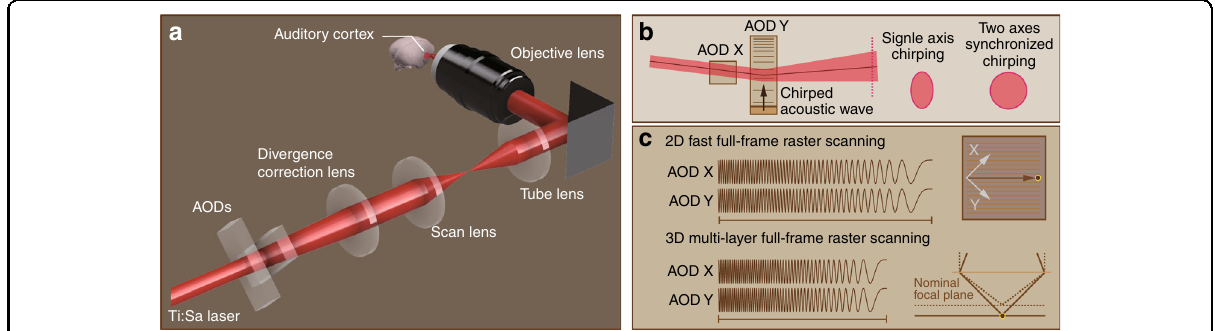
Fig. 1 Con fi guration for silent raster scanning using two AODs. a Excitation light from a Ti:Sa laser is transmitted to an orthogonal pair of AODs. The diffraction generated by the AODs with linear chirping of the control frequency enables rapid control of the output angle without generating an audible sound. b If only one AOD is chirped, the divergence of the emitted light from the AOD changes only with respect to the chirped axis; however, by chirping the two AODs at the same speed, equal divergence is achieved. The equally changed divergence is corrected by the divergence collection lens and subsequently transmitted to the illumination optics of an ordinal two-photon laser-scanning microscope. c A single pair of AODs chirping at the same speed enables raster scanning by scanning the laser in a diagonal direction. By changing the chirping speed, the light coming into the objective lens converges or diverges, and the focal point can be shifted above or below the normal